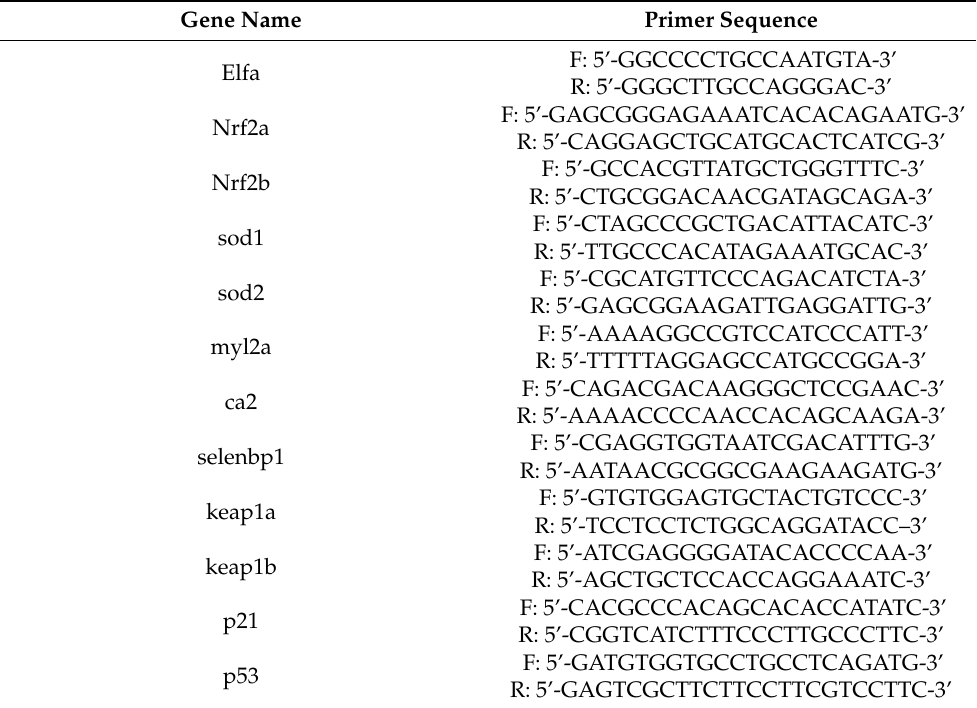
Table 1. Real-time PCR